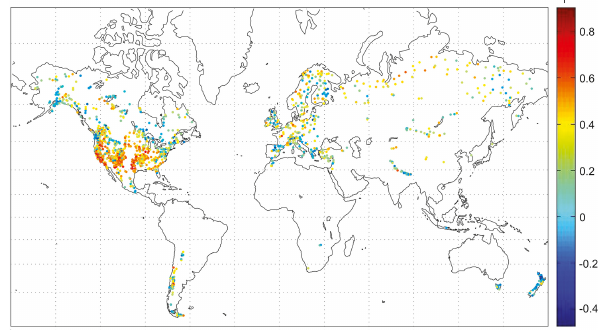
Fig. 1. Locations of the 2287 tree-ring width chronologies (TRW ITRDB ) and the correlation coefficients between TRW ITRDB and TRW VSL for